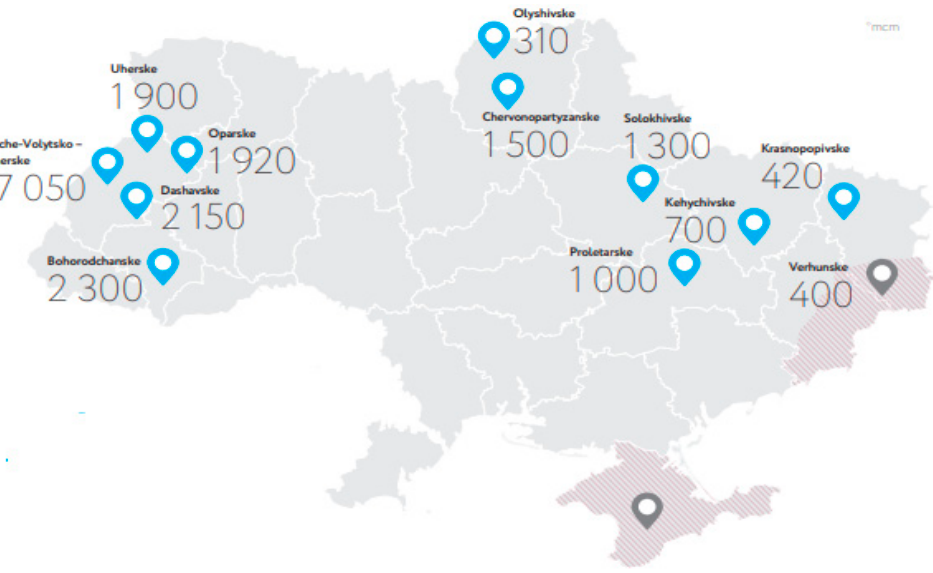
Figure 3. Characteristics of UGS of Ukraine (capacity in million m 3 ). Source: [46].